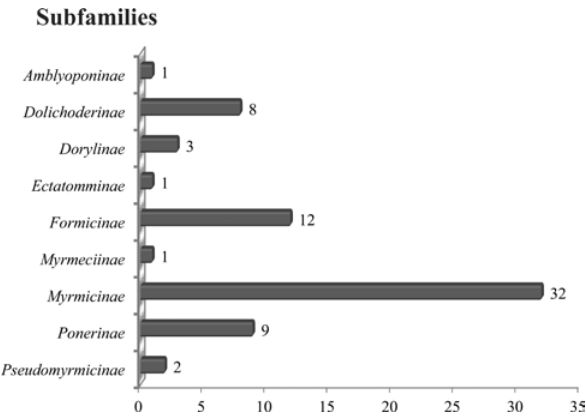
Figure 1. Distribution of the number of species across Formicidae subfamilies with published genome size estimates. The list of species is presented in Table